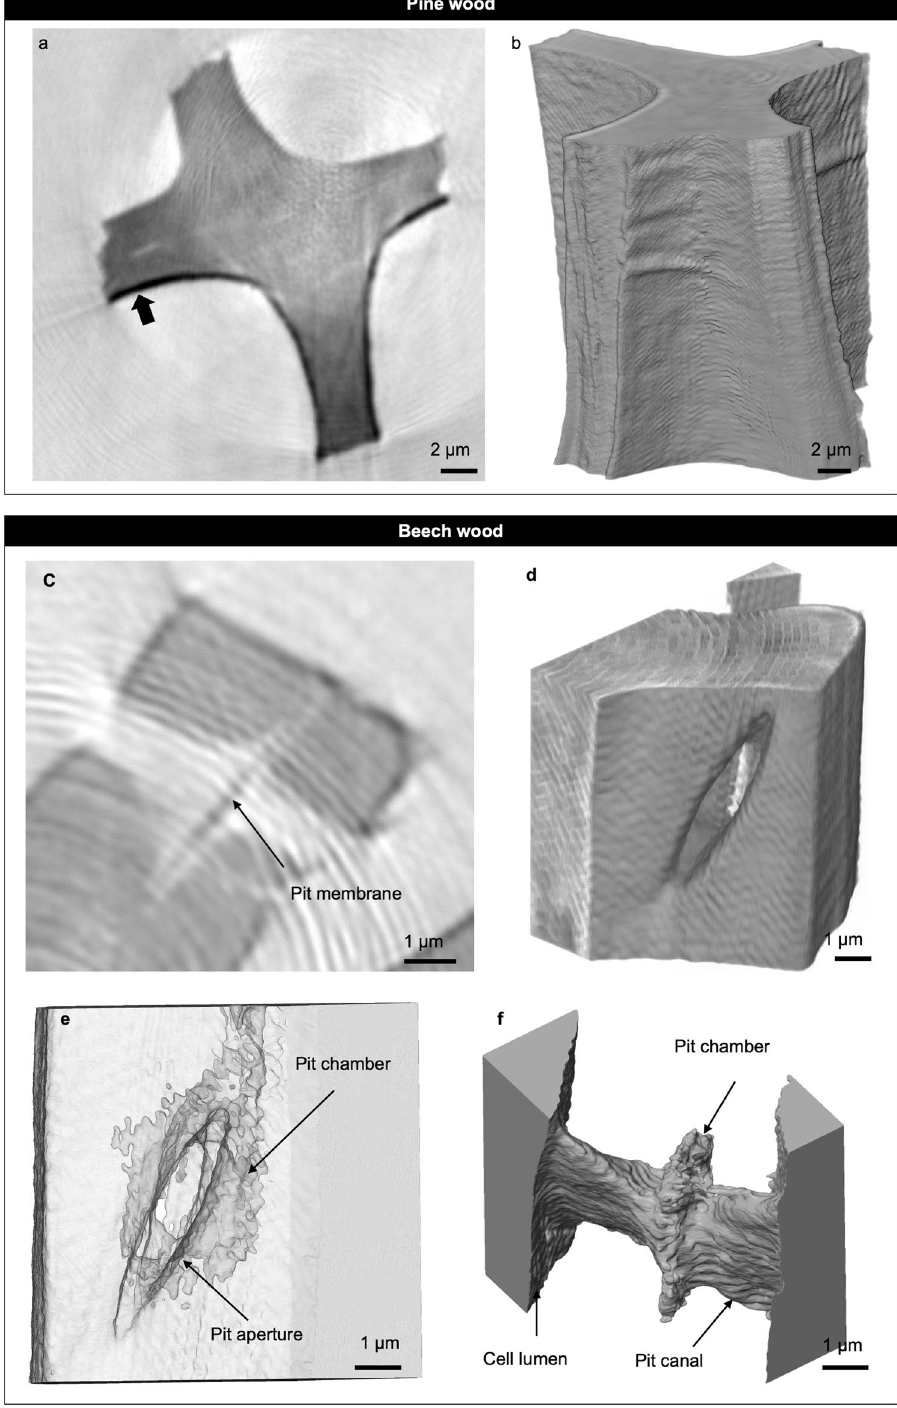
Figure 3. Tomographic imaging of pine and beech earlywood in a dry state. ( a , b ) Cell-wall between tracheids in pine. Scale bars: 2 µm. ( a ) Cross-sectional slice of the sample revealing gallium coating on the cell-wall surface (arrow). ( b ) Volume rendering of the cell wall. ( c – f ) Tomographic visualization of a pit pair between fibrous cells in beech. Scale bars: 1 µm. ( c ) Two-dimensional slice of the ROI. The arrow indicates the pit membrane. ( d ) Volume rendering of the cell wall revealing the one side’s aperture of the pit. ( e ) Transparency cell-wall view reveals the pit chamber in the pit’s center. ( f ) Three-dimensional void visualization of a pit pair connecting the lumina of two neighboring fibrous